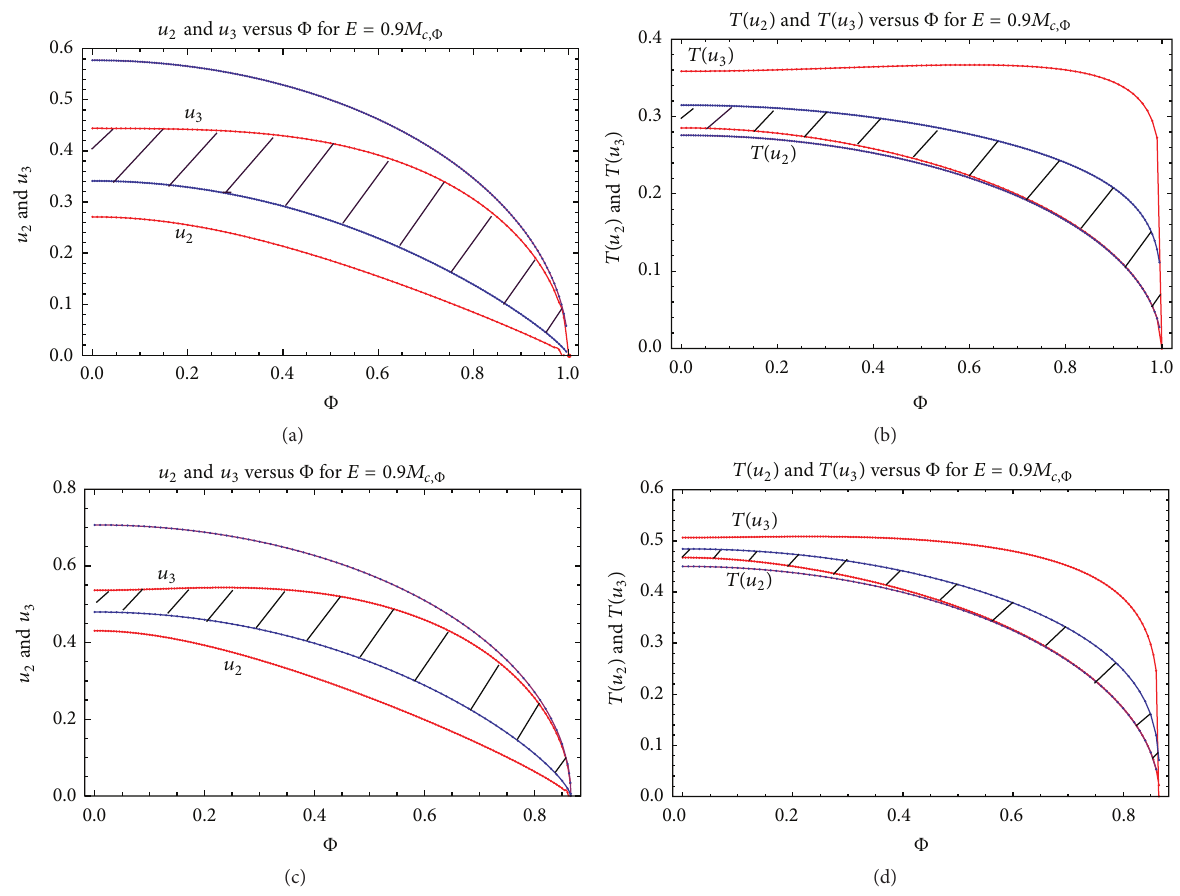
Figure 6: The energy condition 𝐸 < 0.9𝑀 𝑐,Φ overlapping with the heat capacity condition for the fixed potential case. Allowed region is the shade area. In (a) and (b): 𝑢 2 and 𝑢 3 and the corresponding temperatures versus the bulk charge Φ for AdS 4 . In (c) and (d): 𝑢 2 and 𝑢 3 and the corresponding temperatures versus the bulk charge Φ for AdS 5 . For all plots, we set 𝑔 𝑏 = 𝑔 𝑓 = 2